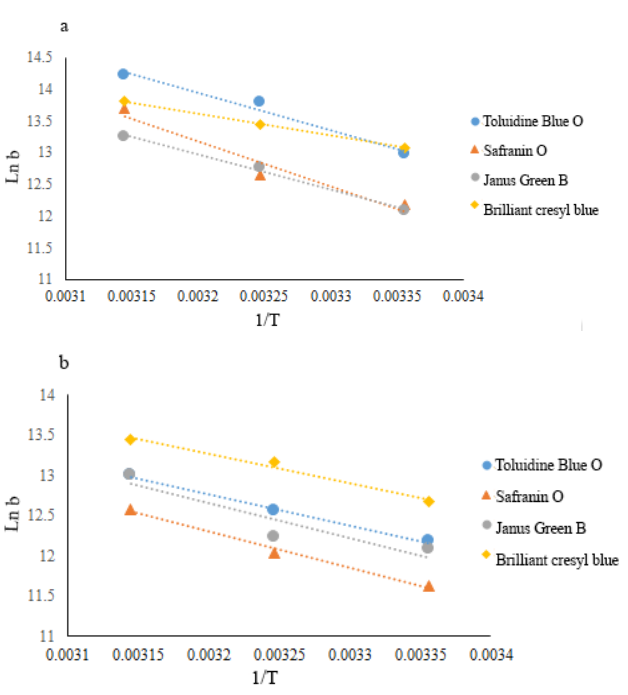
Fig. 5 . Van’t Hoff equation plot of dyes adsorption over (a) TMU-16-NH